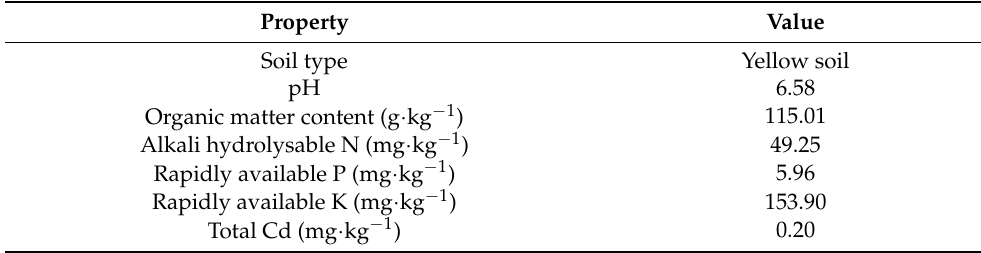
shown in Table 2. Table 2. Basic physical and chemical indicators of soils.